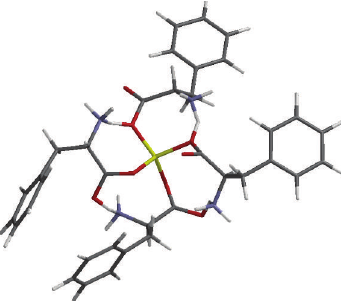
Figure 4: Geometry for the most stable conformation of the Na + - phenylalanine tetramer.